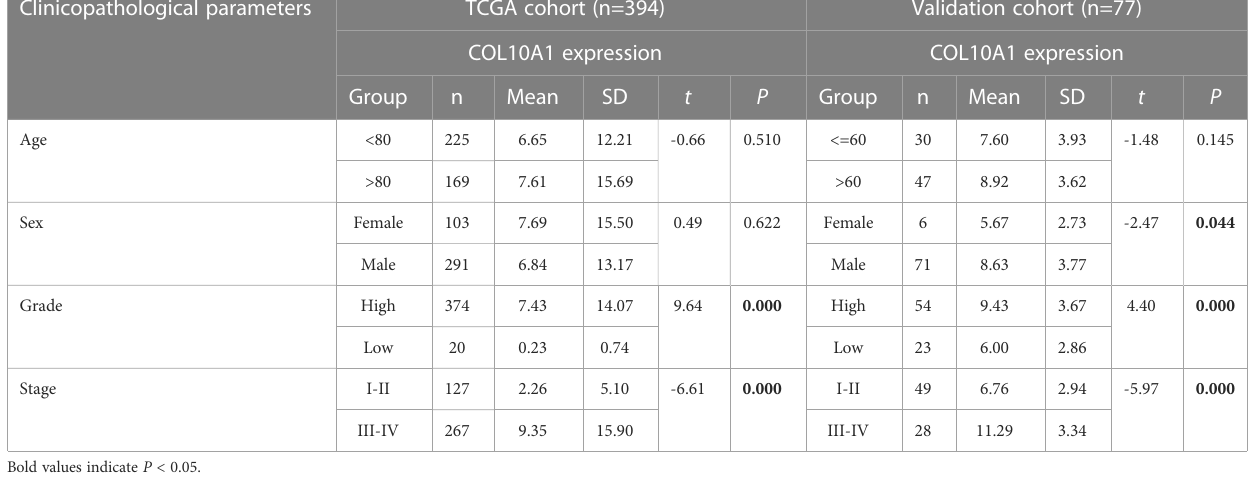
Bold values indicate P < 0.05.